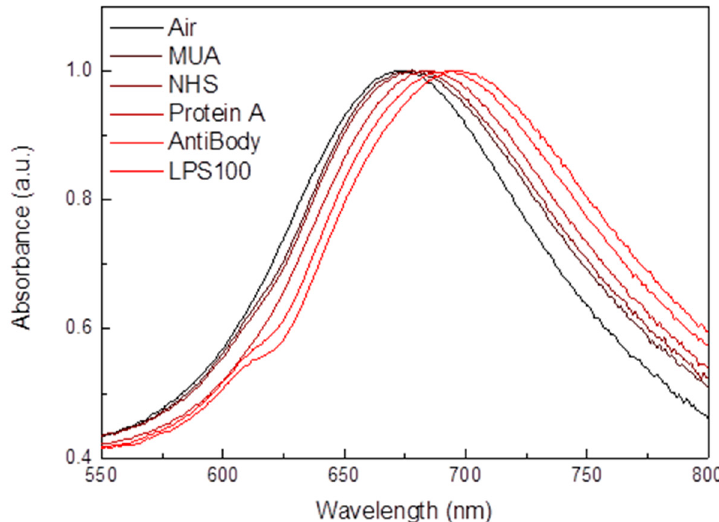
Figure 5. Normalized absorbance spectra of the short-range (SR) homogeneous distribution of Au nano-disks acquired during the biosensing measurements for the detection of Lipopolysaccharides (LPS) molecules. Absorbance spectra for each step of the functionalization process and also one LPS concentration are reported.